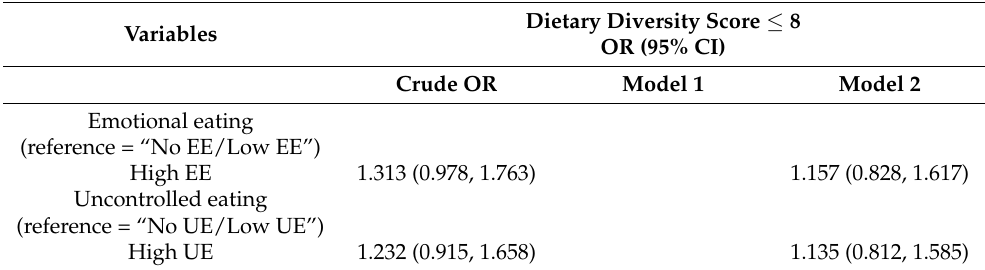
Model 1: adjusted for sex, age, registered residence, monthly expenditure, major, physical activity, perceived stress, anxiety symptoms, depressive symptoms, and satisfaction to body image; Model 2: additionally adjusted for emotional eating and uncontrolled eating; * p < 0.05; EE: emotional eating; UE: uncontrolled eating. OR, odds ratio. 95% CI, 95% confidence